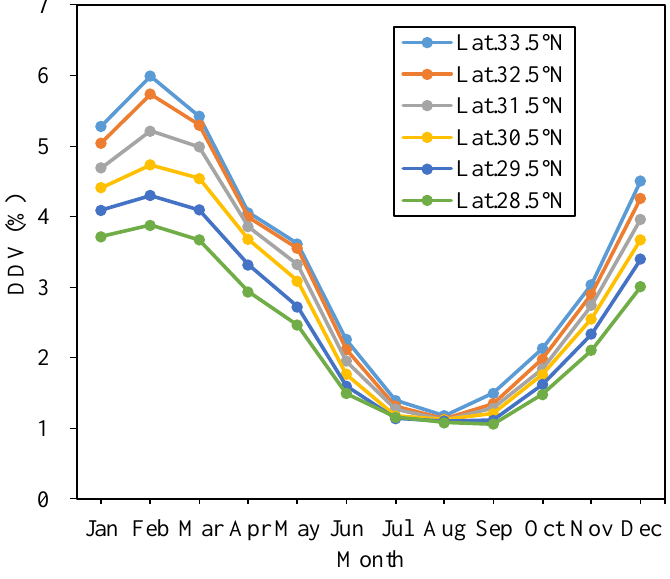
Figure 8. The monthly average day-to-day variability (DDV) for the six latitudinal bands over the Yangtze River Delta from 1978 to